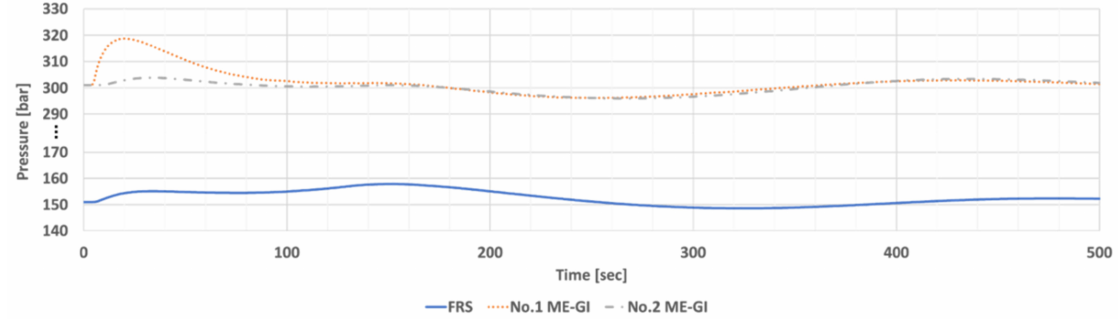
Figure 13. Pressure of each line when one engine is